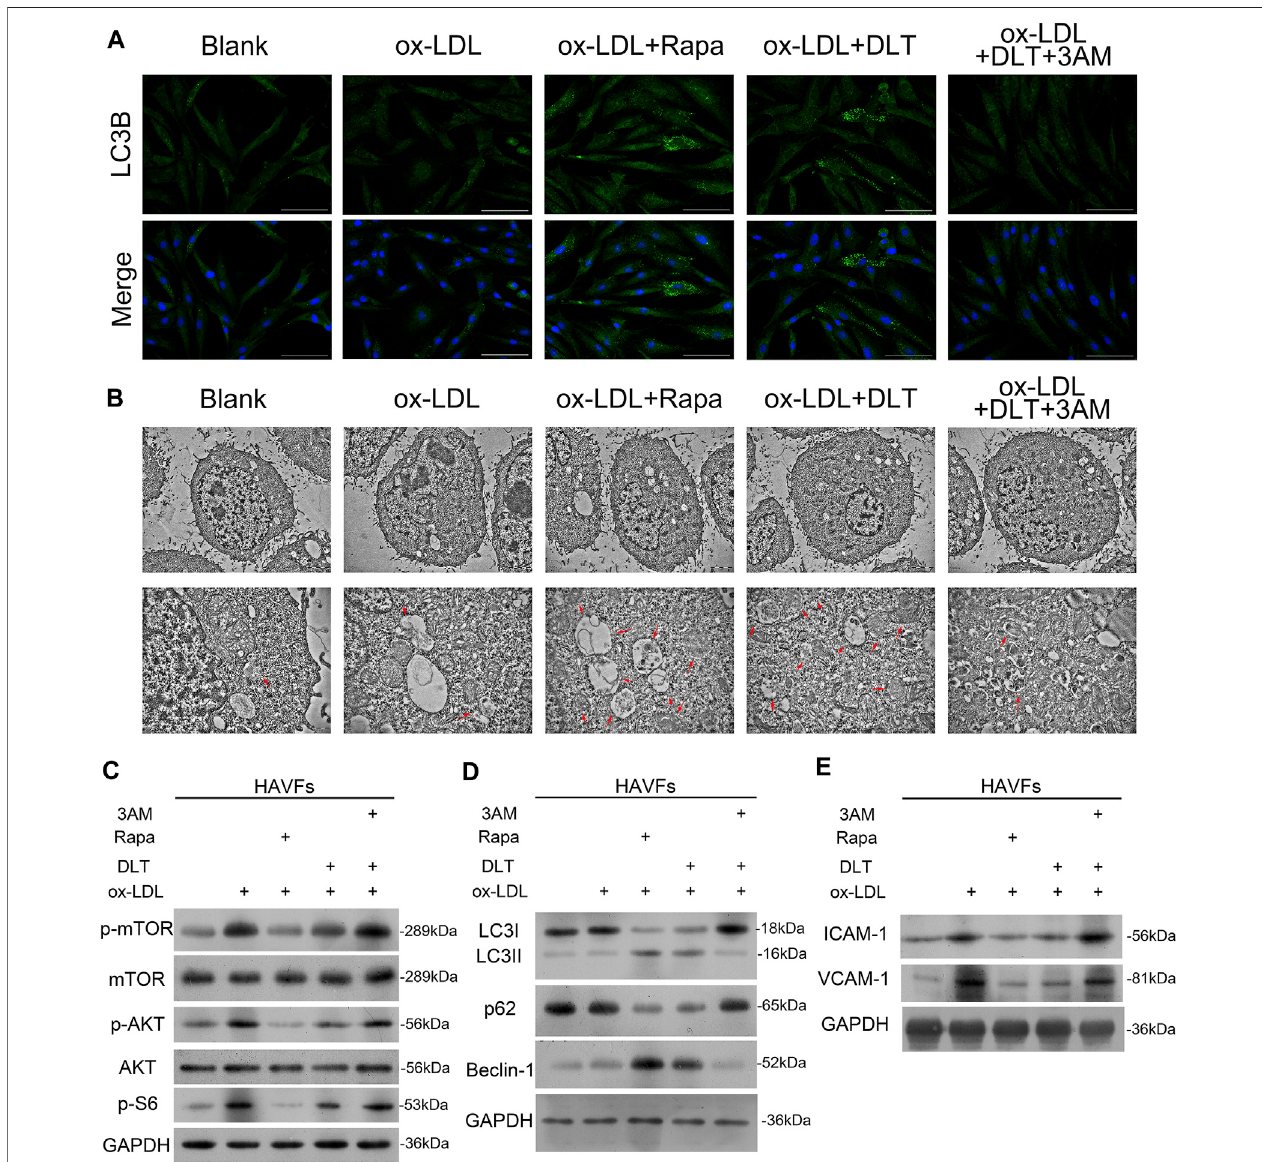
FIGURE 6 | mTOR pathway agonist decreases autophagy by DLT in the AS model. (A, B) Immuno fl uorescence staining of LC3 and transmission electron microscopy analysis to show the activation of autophagy in the DLT treatment group and inhibition by the mTOR agonist. (C) Western blot showed the activation of the PI3K/Akt-mTORpathwaybythemTORagonist. (D) TheautophagymarkerexpressionwasdetectedbywesternblottingandreducedintheDLT-mTOR agonistdouble treatment group. (E) The HVAFs activation markers ICAM-1 and VCAM-1 were checked in the DLT-mTOR agonist double treatment group.